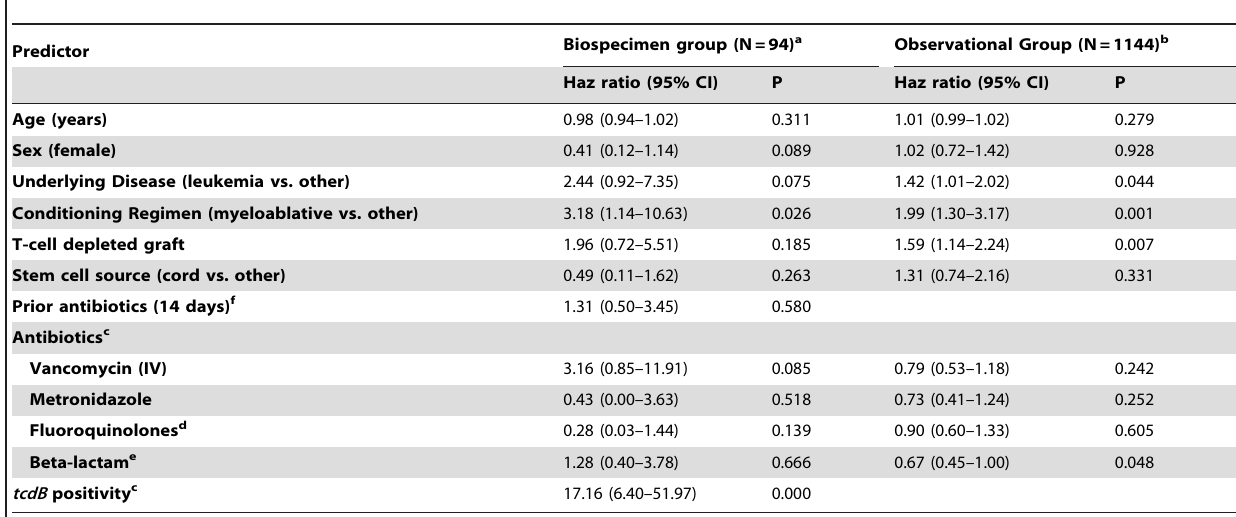
Predictor Biospecimen group (N=94)